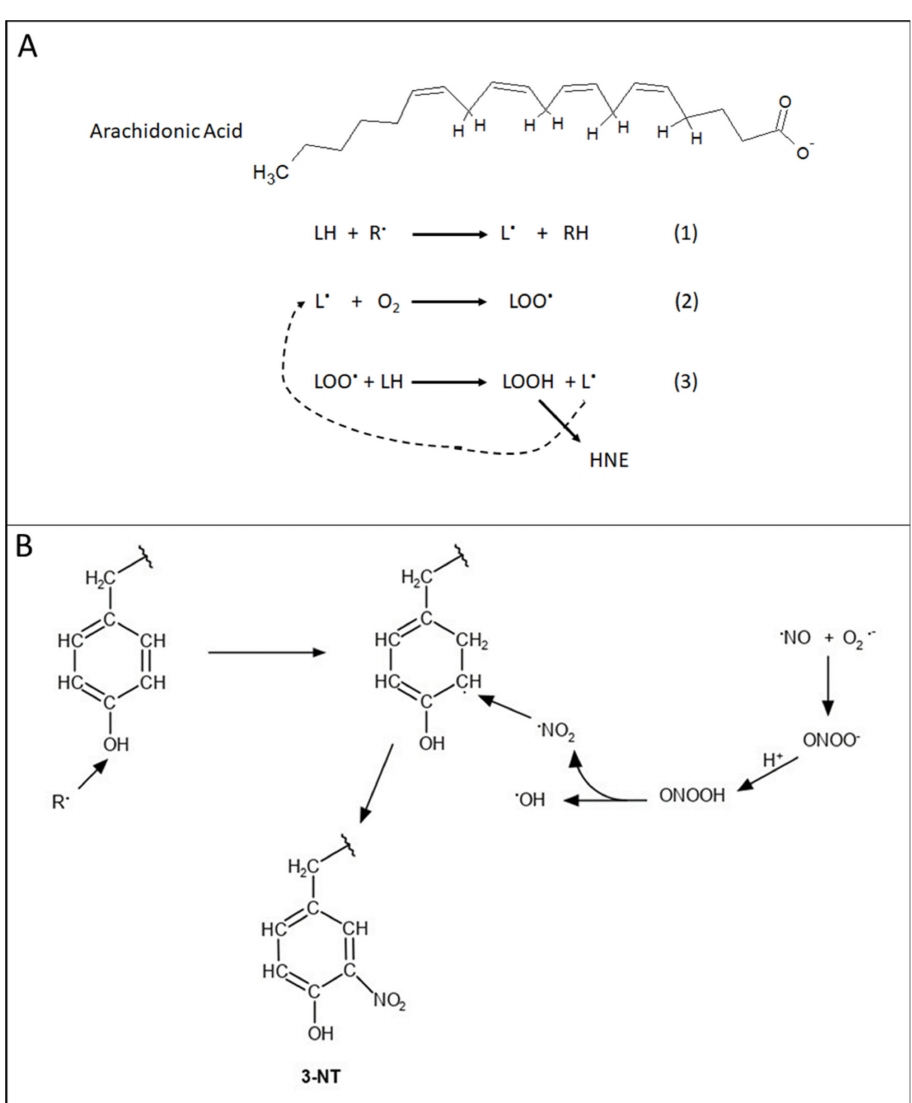
Figure 2. ( A ) Mechanism of lipid peroxidation. Arachidonic acid structure showing labile allylic H-atoms that are subject to free radical-mediated abstraction (Rxn 1) leading to carbon-centered free radical on the lipid-resident arachidonic acid carbon backbone. Paramagnetic molecular oxygen, in a radical–radical recombination reaction (Rxn 2), produces the lipid-bound peroxyl free radical. This latter free radical abstracts another labile allylic H-atom (Rxn 3) to form the lipid hydroperoxide and another carbon-centered free radical. Then, this latter radical takes part in Rxn 2 again, i.e., a chain reaction, that will continue as long as there are molecular oxygen and allylic H-atoms present. The lipid hydroperoxide is decomposed into reactive aldehydes, including the highly reactive 4-hydroxynonenal (HNE). See text for additional details. ( B ). Formation of 3-nitrotyrosine. Nitric oxide (NO), a free radical produced by nitric oxide synthase from arginine, reacts with superoxide free radical anion (see Figure 1) by radical–radical recombination to form peroxynitrite, ONOO − . The actual next reaction shown is more complicated than depicted, but in essence, the protonation of peroxynitrite forms peroxynitrous acid that decomposes into the free radical nitrogen dioxide (NO 2 ) and hydroxyl free radical. Tyrosine, attacked by a free radical R . to remove the H-atom of the phenolic OH group, leaves an unpaired electron on the O-atom that delocalizes to the 3-position of tyrosine with the H-atom removed from the 3-position, reforming the OH functional group on Tyr. NO 2 reacts with the delocalized unpaired electron on the 3-position of tyrosine residues in a radical–radical recombination reaction to form 3-nitrotyrosine (3-NT), which is a major marker of nitrosative stress. See the text for further